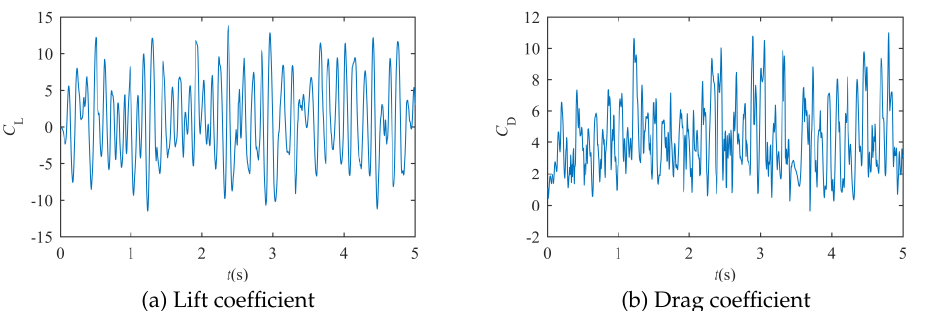
Fig. 14. Time history diagram of aerodynamic coefficient variation of positive feeder with double walls